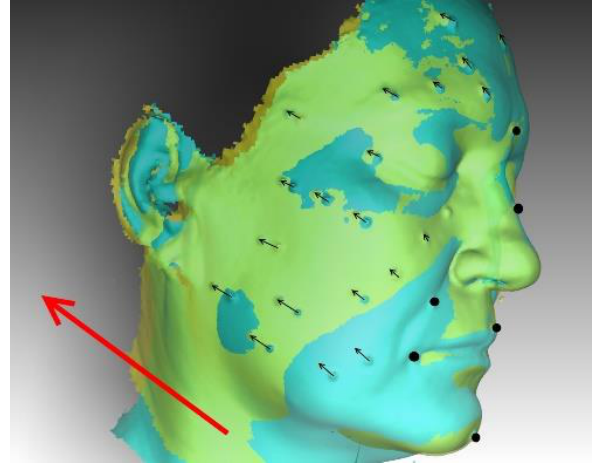
Figure 4. The variation of gravity test with marks. The little migration over the zygomatic arch is